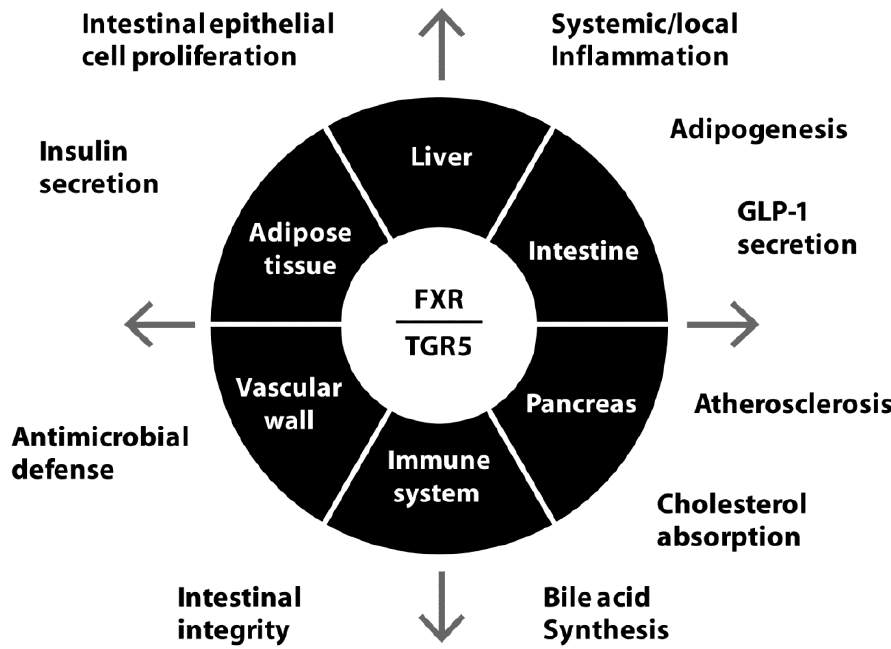
Figure 2. Schematic overview of the expression and functions of FXR and TGR5. See Sections 3 and 4 for details. White on black; Tissue or cellular expression of FXR and TGR5. Black on white; Functions of FXR and